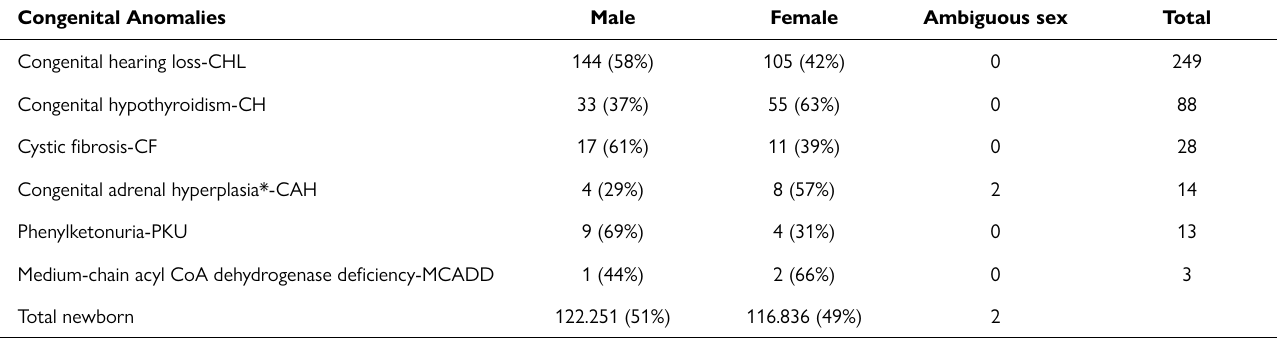
Table 4. Sex distribution of newborns diagnosed by the Newborn and Infant Screening Programme in Uruguay between 2010 and 2014. Congenital Anomalies